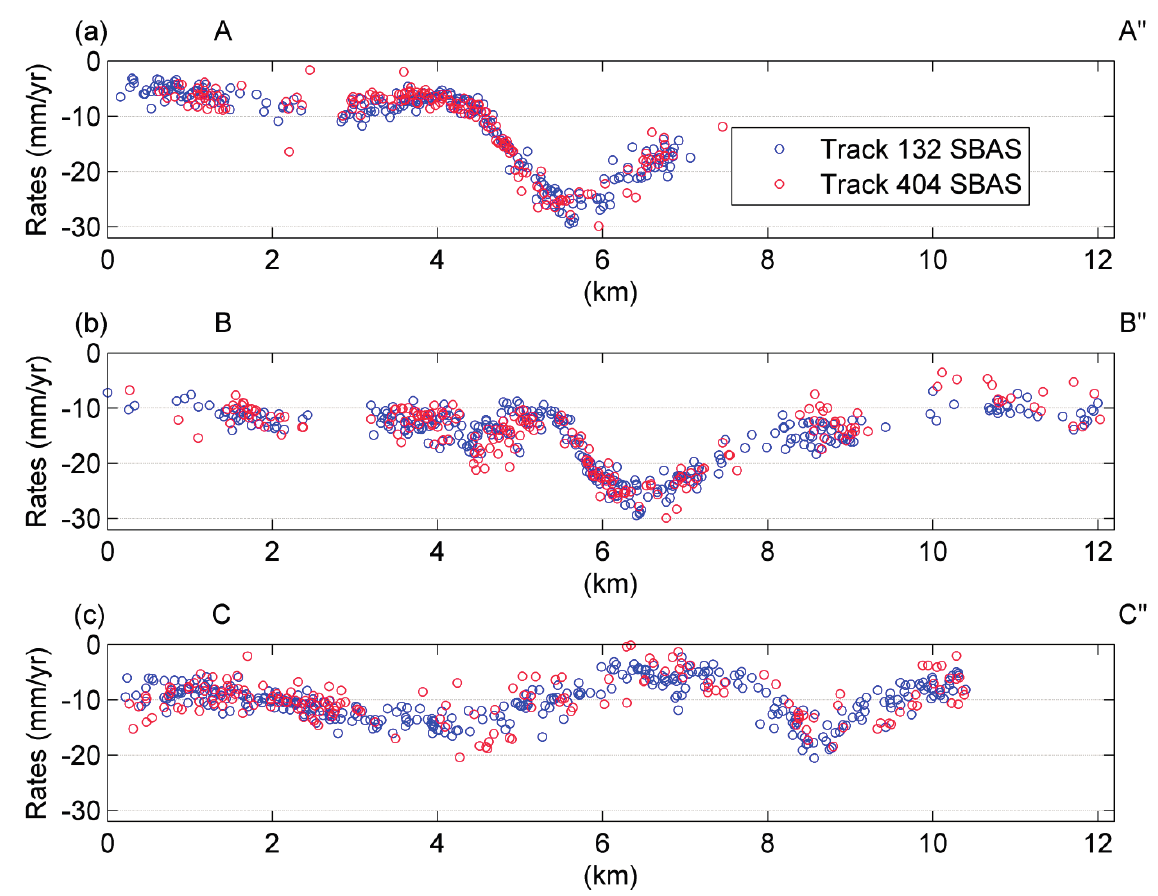
Figure 6. Displacement rates of the Yellow River delta estimated from small baseline interferograms for Tracks 132 and 404. Positions of three 500 meter wide swaths A-A", B-B" and C-C" are marked in Figure 5a. Note the consistency in results from the two